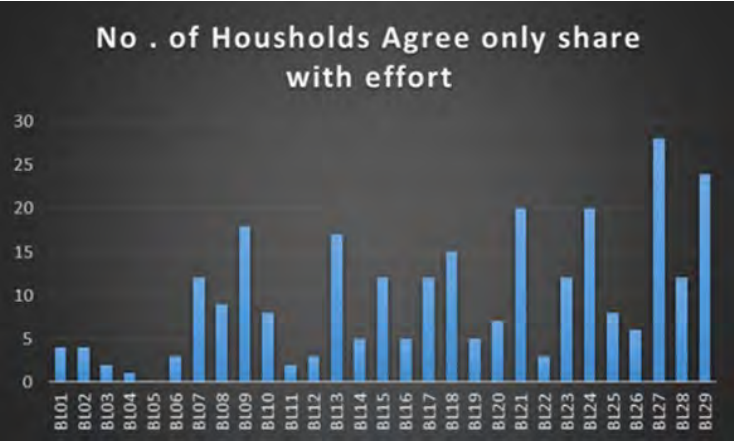
Figure 20. No. of Housholds Agree only share with effort